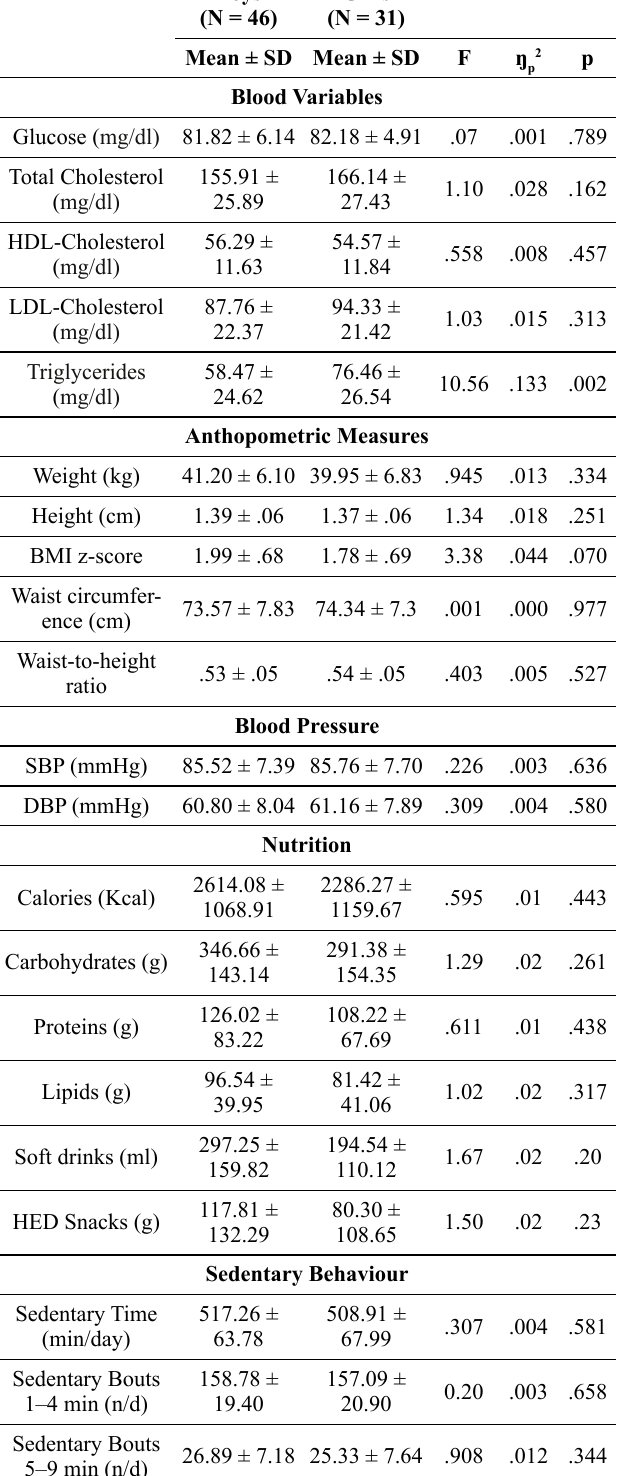
Table II. Comparative analysis of anthropometric measures, cardio - respiratory fitness, physical activity, sedentary behaviours and blood pressure of the total sample according to